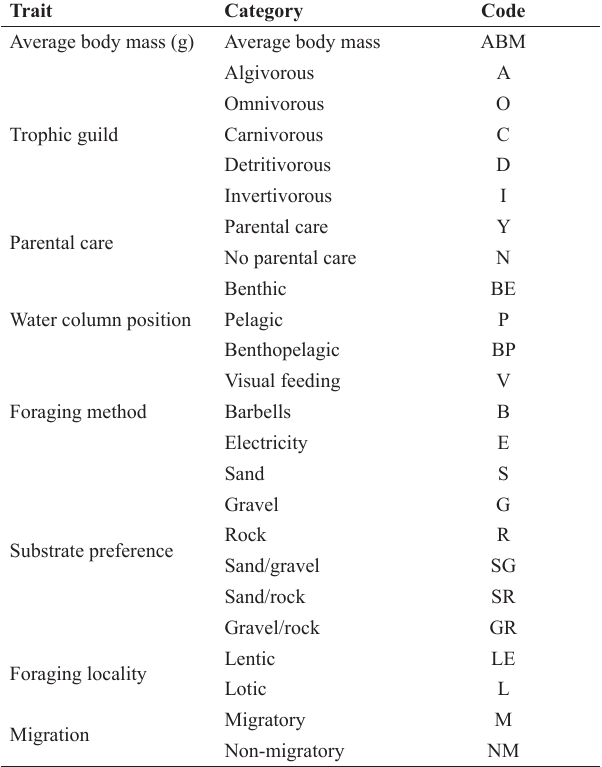
Table 1. Category and codes by functional trait of fish species sampled in 25 headwater streams of Araguaia and Tocantins river